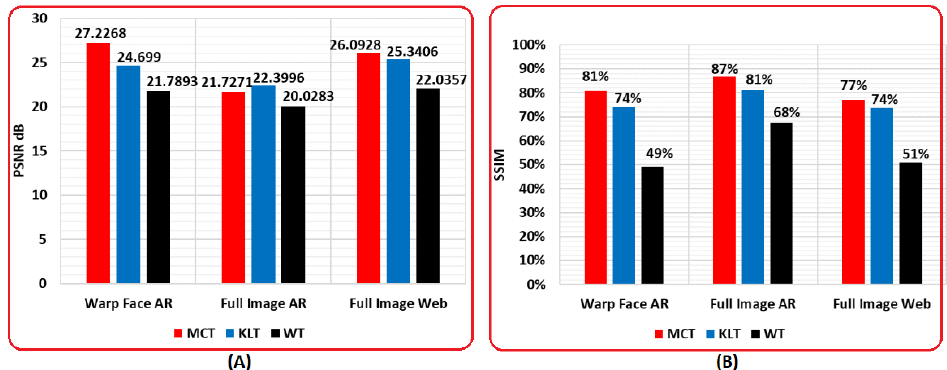
Figure 17. A comparative evaluation using ( A ) PSNR and ( B ) SSIM across all used